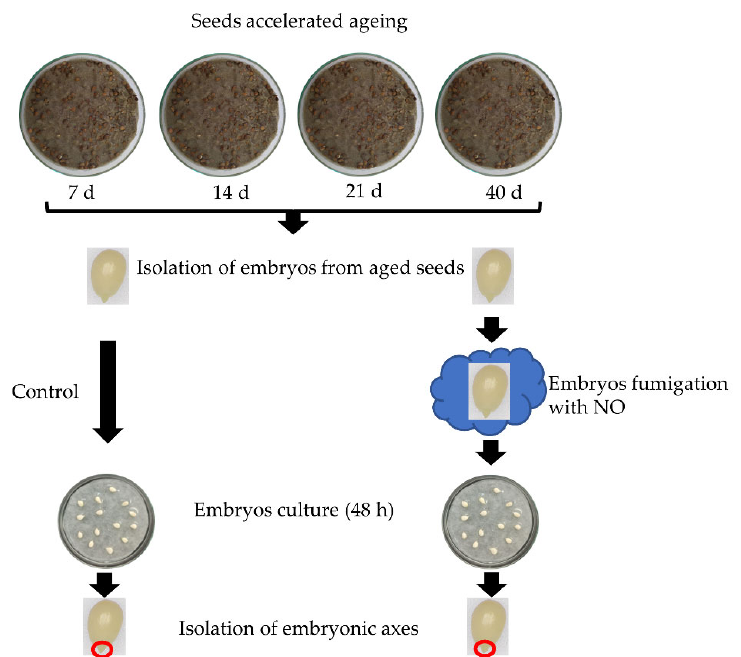
Figure 1. The scheme of the experimental model. Apple seeds were aged for 7, 14, 21 or 40 days on Petri dishes filled with moisture sand at 33 °C. After accelerated ageing of the seeds, embryos were isolated and part of them was fumigated with NO. Embryos non ‐ treated with NO were used as a control. Embryos (control and NO treated) were cultured for 48 h and the embryonic axes were isolated and used for biochemical and transcriptomic analysis. The germination rate of the embryos and morphology of developing seedlings were determined after 7 days of the culture.